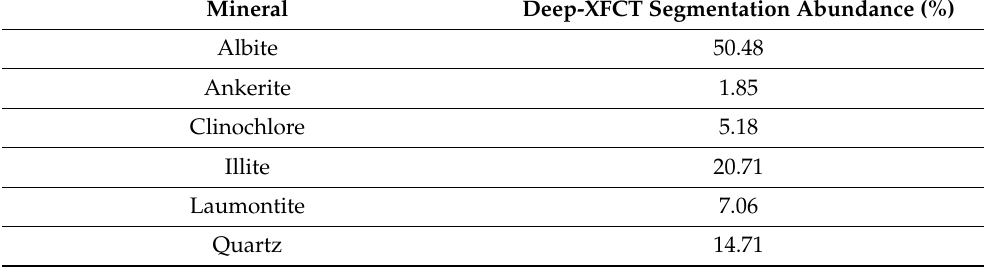
Table 4. Abundance percentage of each mineral obtained from segmentation with the deep learning